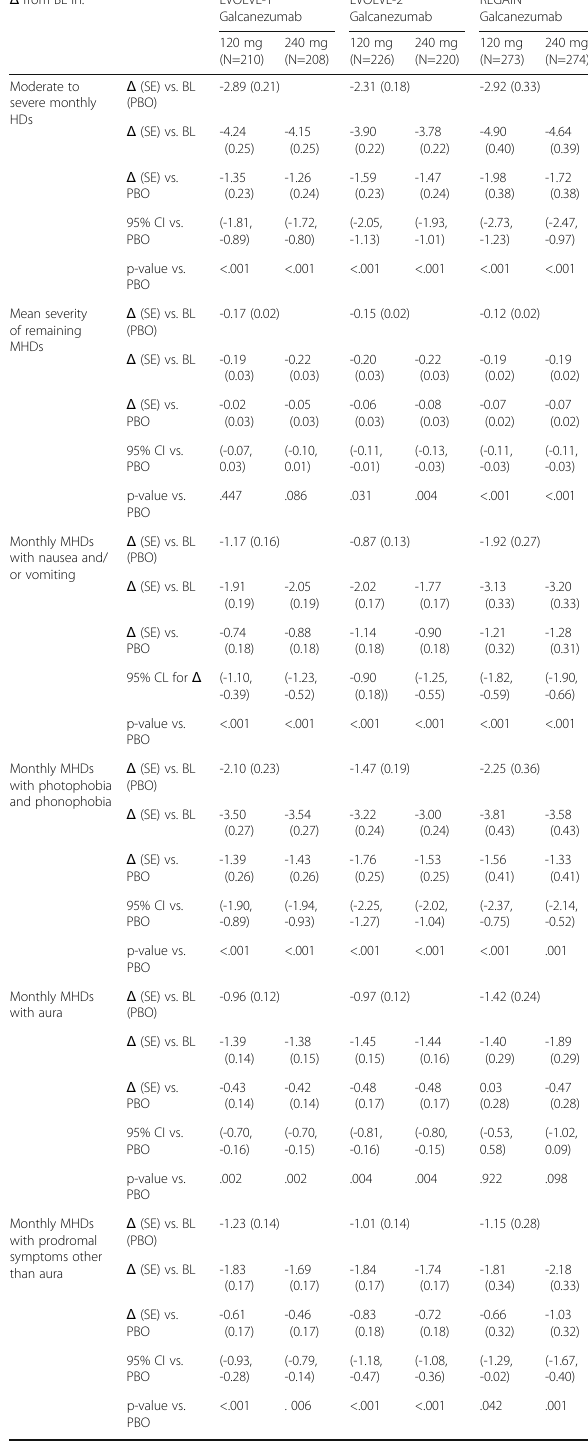
Table 1 (abstract O31). Summary of overall results Δ from BL